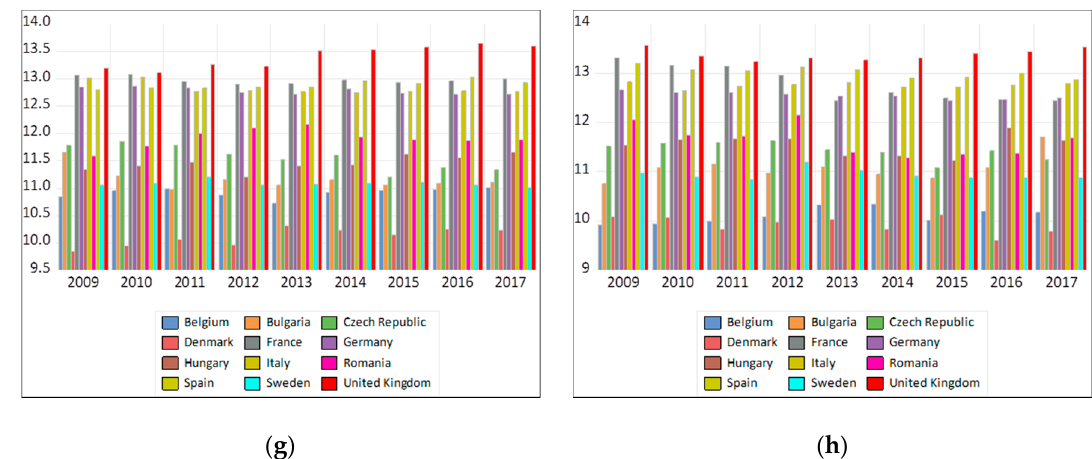
Figure 1. The time evolution for the analyzed data series: ( a ) nominal labor productivity per person; ( b ) GDP per capita; ( c ) population of active enterprises; ( d ) births of enterprises; ( e ) deaths of enterprises; ( f ) persons employed in the population of active enterprises; ( g ) persons employed in the population of births; ( h ) persons employed in the population of deaths. Source: the authors, based on Eurostat (2020).